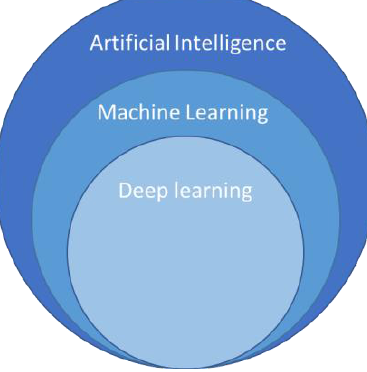
Figure 4. Deep learning